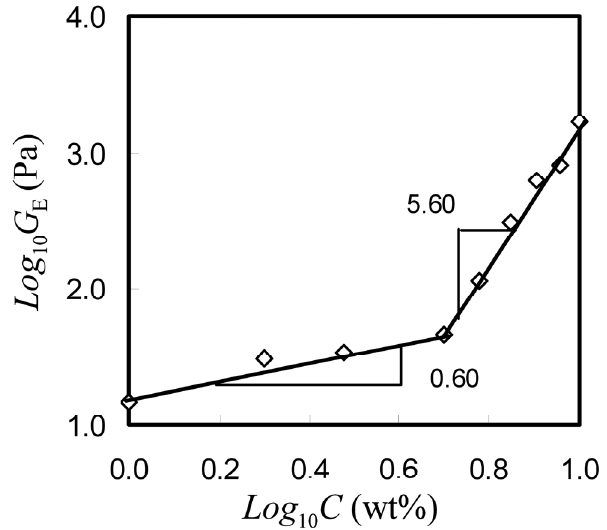
G for HPMC in the presence of SIF (8.3 g/L) E